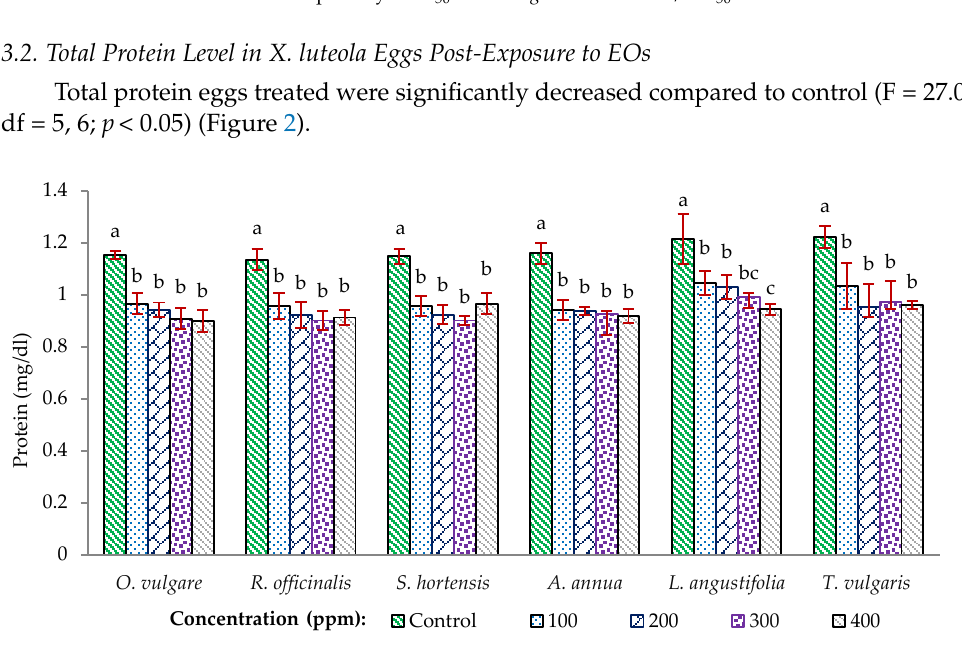
Figure 2. Effect of different concentrations of essential oils on the total protein (mg/dL) of Xanthogaleruca luteola eggs. Statistical differences are shown by different letters according to Tukey’s test at p ≤ 0.05.